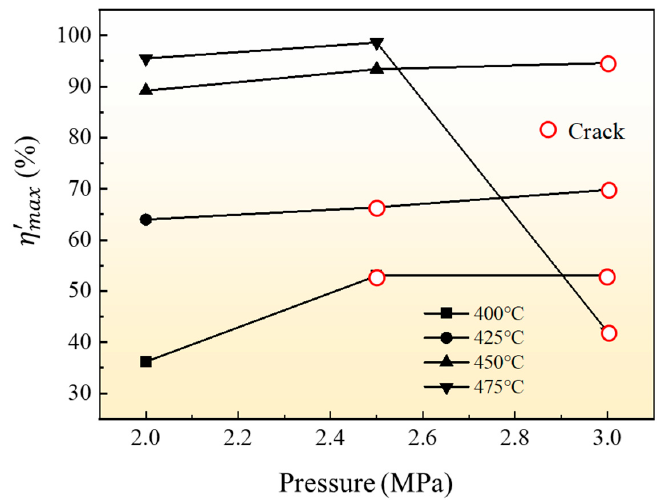
Figure 19. η (cid:48) max of 6063 aluminum alloy tube at different forming Figure 19. 𝜂 (cid:3040)(cid:3028)(cid:3051) (cid:4593) of 6063 aluminum alloy tube at different forming parameters.